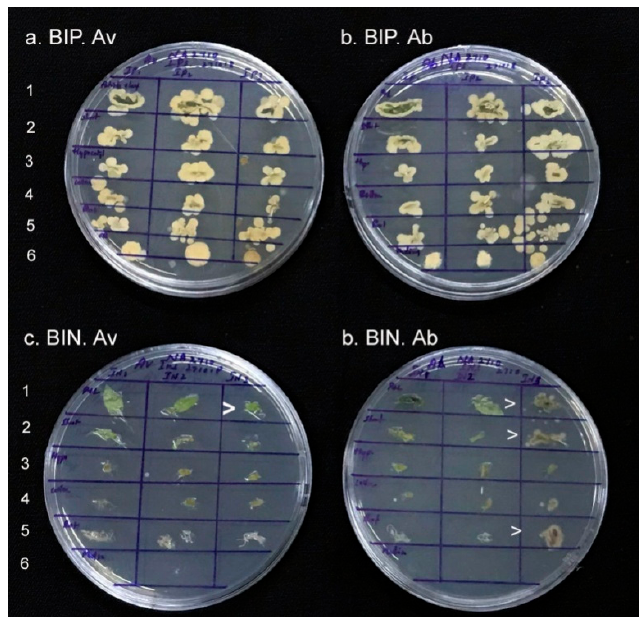
Figure 6. Monitoring the tissue parts from the different parts of index-positive (BIP) seedlings and index-negative (BIN) 6 week old in vitro seedlings of tomato. ( a, b ) surface sterilized BIP seedlings of “Arka Vikas” and “Arka Abha”, respectively, and ( c, d ) BIN seedlings tested directly. 1–6 stands for leaf/ petiole, shoot tip, upper hypocotyl, collar region, roots and growth medium, in that order, and the arrow-head denotes bacterial growth from BIN seedlings.